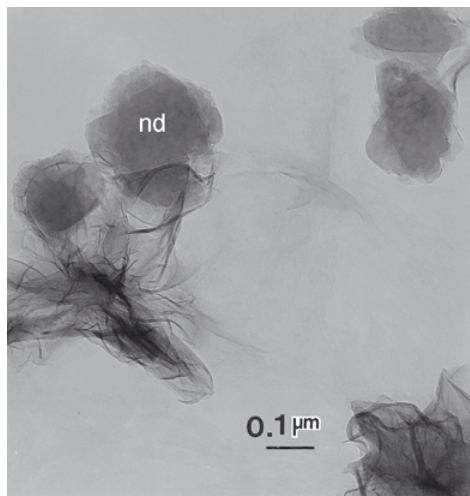
Figure 6. Nordstrandite particles (nd) and pseudoboehmite fibrils are still connected. However, there are less fibrils and the particles are larger.